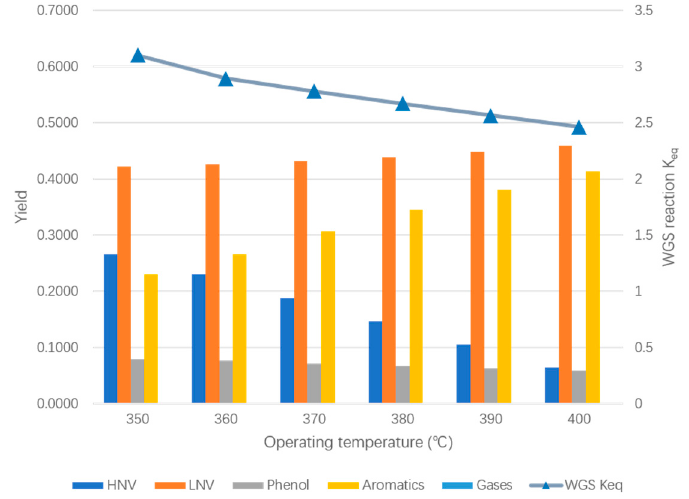
Figure 7. Impacts of operating temperature on product distribution. WGS refers to water–gas-shift reaction; K eq refers to the reaction equilibrium constant.